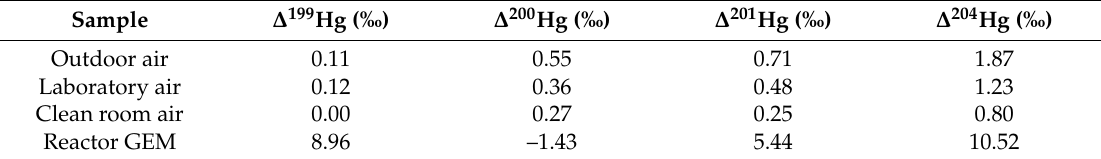
Table 6. Calculated ∆ x Hg values for the air and laboratory experimental